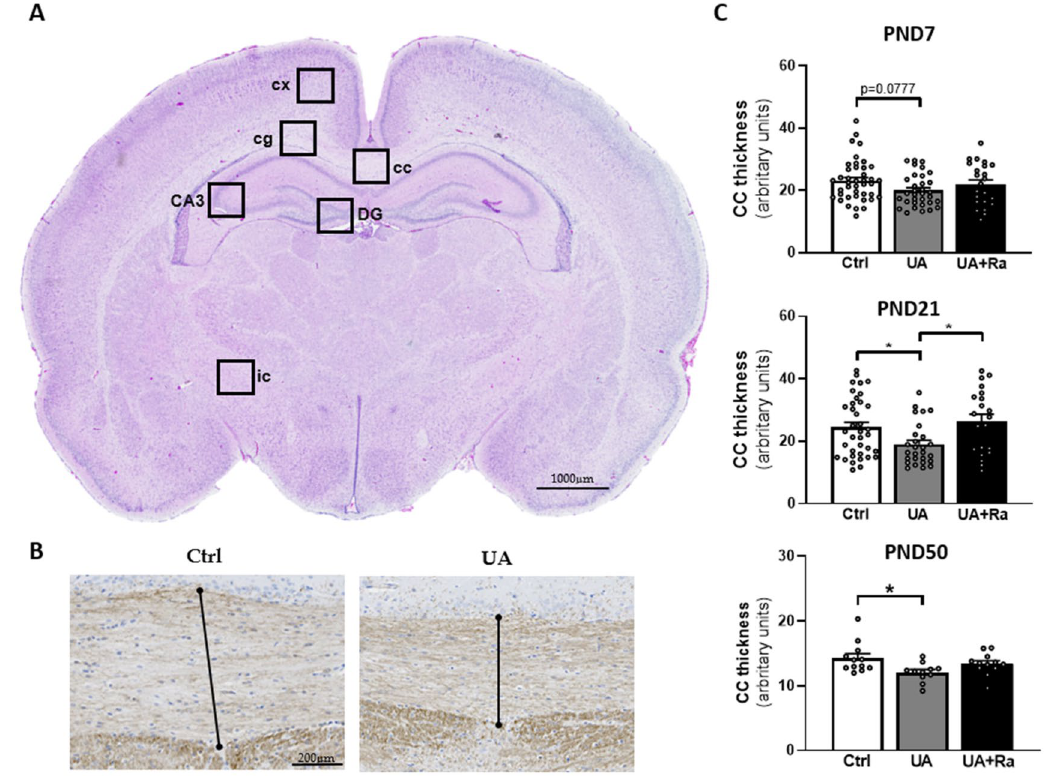
Figure 2. Morphological brain alteration following uric acid exposure. Representative image of HE staining of the brain regions studied ( A ). Representative image of MBP staining at PND21 to measure the corpus callosum thickness ( B ) and quantification at different postnatal time ( C ). cc corpus callosum, cg cingulum, cx cortex, DG hippocampus-dentate gyrus, 3‑CA 3 hippocampus-cornus amonis, ic internal capsule. N = 8–16 litters (i.e. PBS = 11; IL-1Ra = 8; UA = 16; UA + Ra = 12). *p < 0.05; **p < 0.01; ***p < 0.001. Results presented as mean ± SEM. Statistical analysis by one-way ANOVA with Tukey’s multiple comparisons test with GraphPad Prism 9.2.0 (GraphPad Software, CA); www. graph pad.